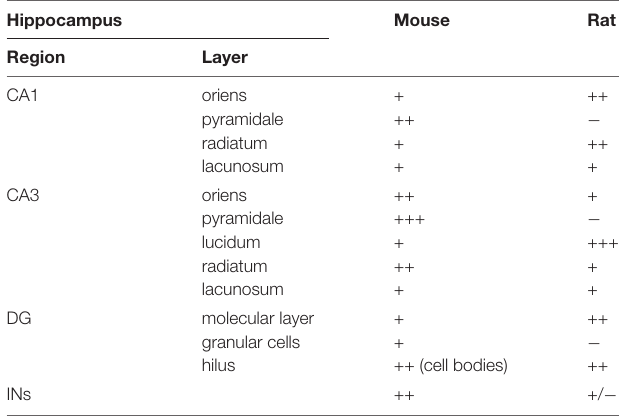
TABLE 2 | Summary of the SNAP47 protein distribution according to regions and layers in the mouse and the rat hippocampus (SNAP47 immunoreactivity: +++, strong; ++, moderate; +, weak; − , virtually